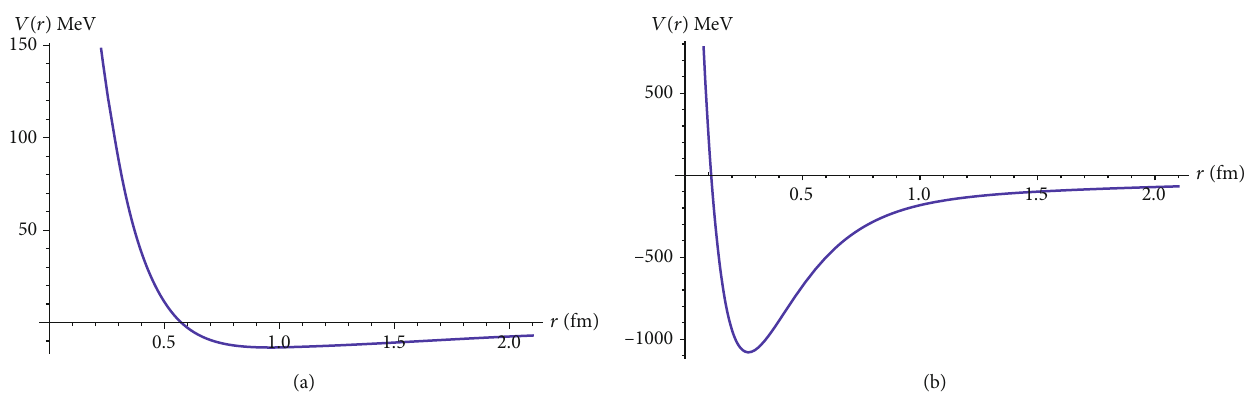
Figure 5: The potential with GY and SPED functions, respectively, of 2 H nuclei as OBEP through the exchange of π , σ , and ω mesons, with parameter